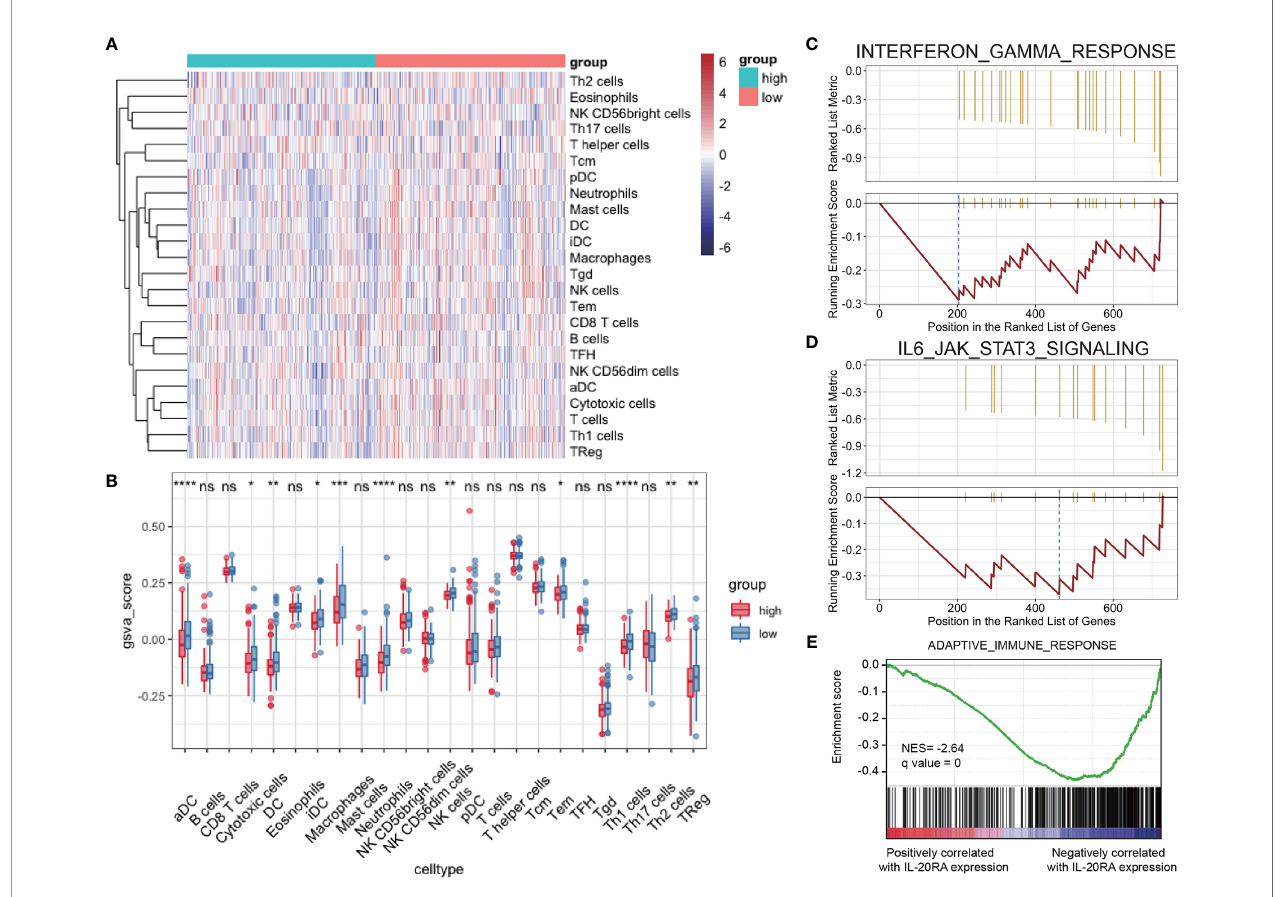
FIGURE 6 | IL-20RA was related to in fi ltration level of immune cells. (A, B) Heatmap and boxplot derived from gene set variation analysis showing varied levels of in fi ltrating immune cells between high- and low-IL-20RA groups. (C-E) Gene set enrichment analysis of genes related to IFN- g response (C) , IL-6-Jak-STAT3 (D) and adaptive immune response (E) in genes positively or negatively correlated with IL-20RA expression. *P < 0.05, **P < 0.01, ***P < 0.001, ****P < 0.0001, NS, no signi fi